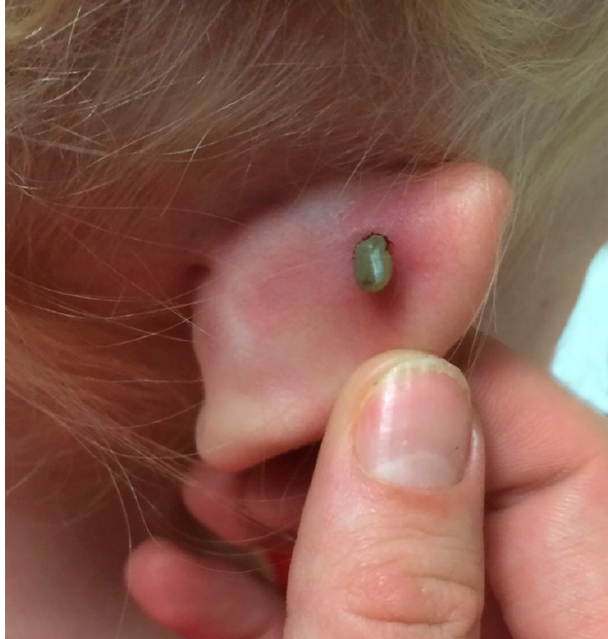
Figure 1. A blacklegged tick female parasitizes the ear of a seven-year-old girl. Based on the size of this partially engorged female, it had been feeding for four days. When the tick bites its host, the hypostome secretes a compound that anesthetizes the skin at the point of entry. Consequently, the majority of patients do not recall a tick bite.